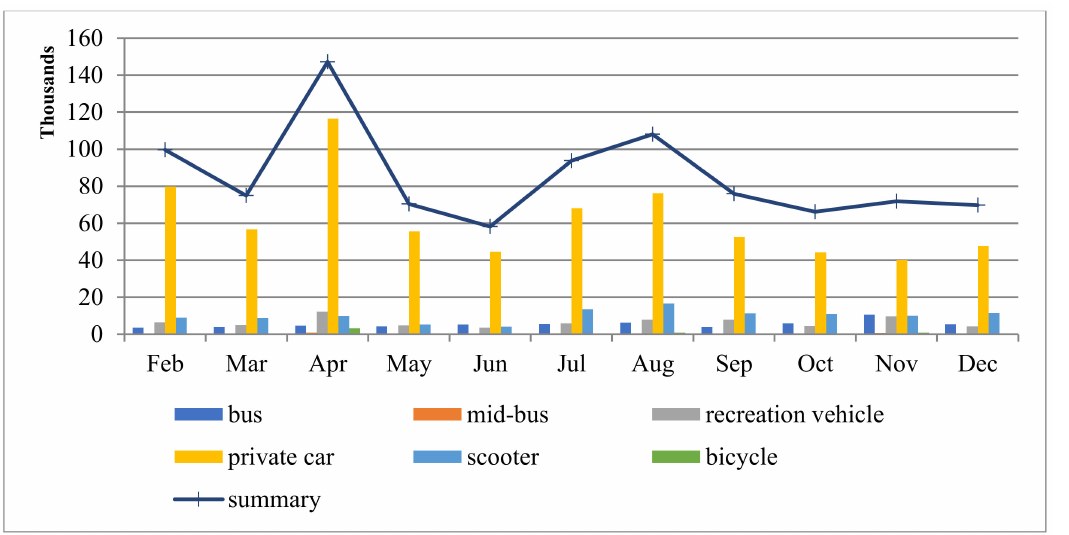
Figure 5. Types and individual number of transportations to Kenting National Park in 2011 (Note: data from [62]).